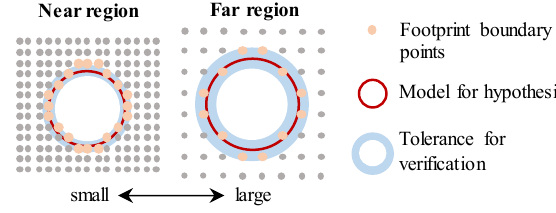
Figure 4. Adaptive model and tolerance in RANSAC